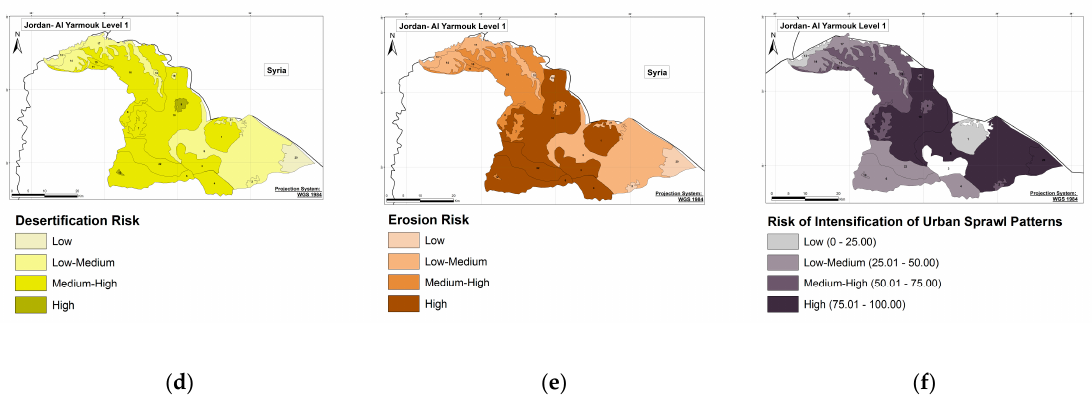
( f ) Figure 10. Hazard Maps for LDU’s of Desertification (left), Erosion (middle), and Intensification of urban sprawl (right) in Greece: Epirus ( a – c ) and Lesvos ( d – f ).